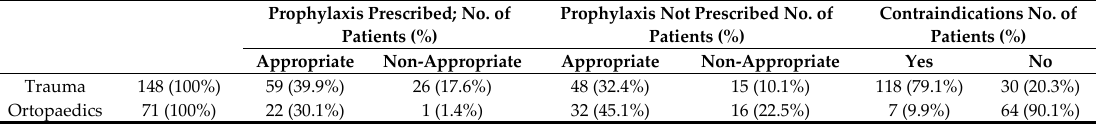
Table 1. The prescribed VTE prophylaxis in trauma and orthopaedic patients on a pre-specified day.